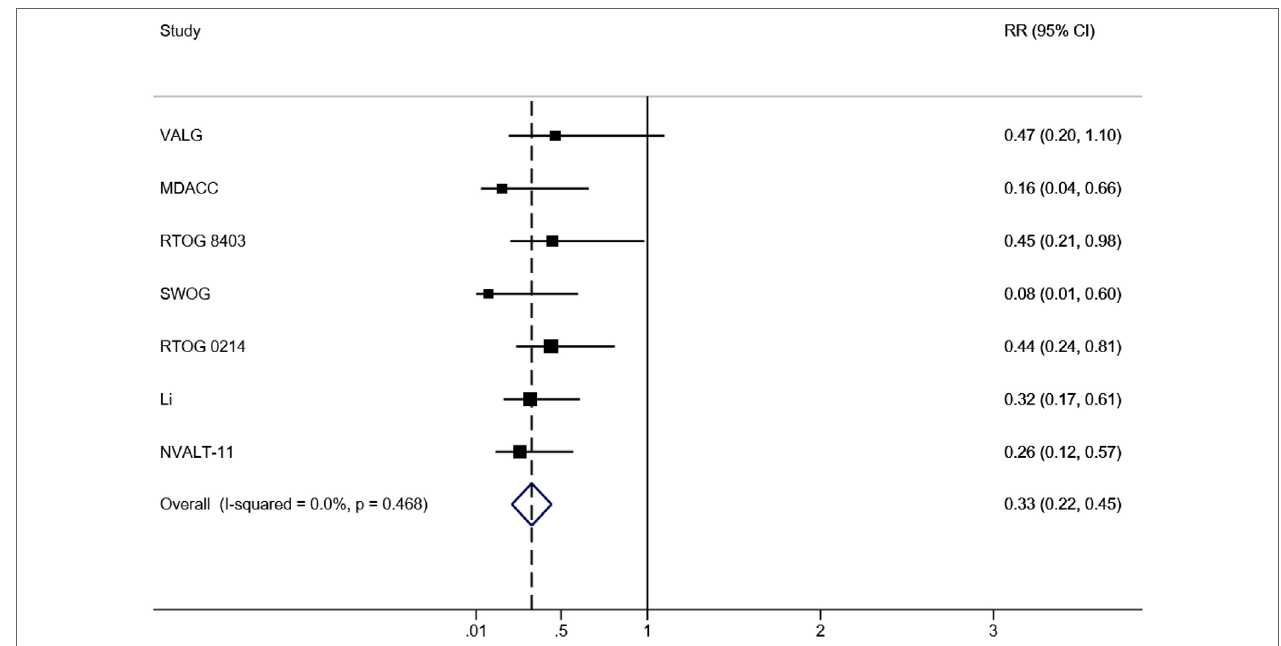
FigURe 2 | Forrest plot of the meta-analysis of RCTs evaluating the effect of PCI on BM in NSCLC. Abbreviations: RR, relative risk; 95% CI, 95% confidence interval; RCTs, randomized controlled trials; PCI, prophylactic cranial irradiation; BM, brain metastases; NSCLC, non-small cell lung cancer.